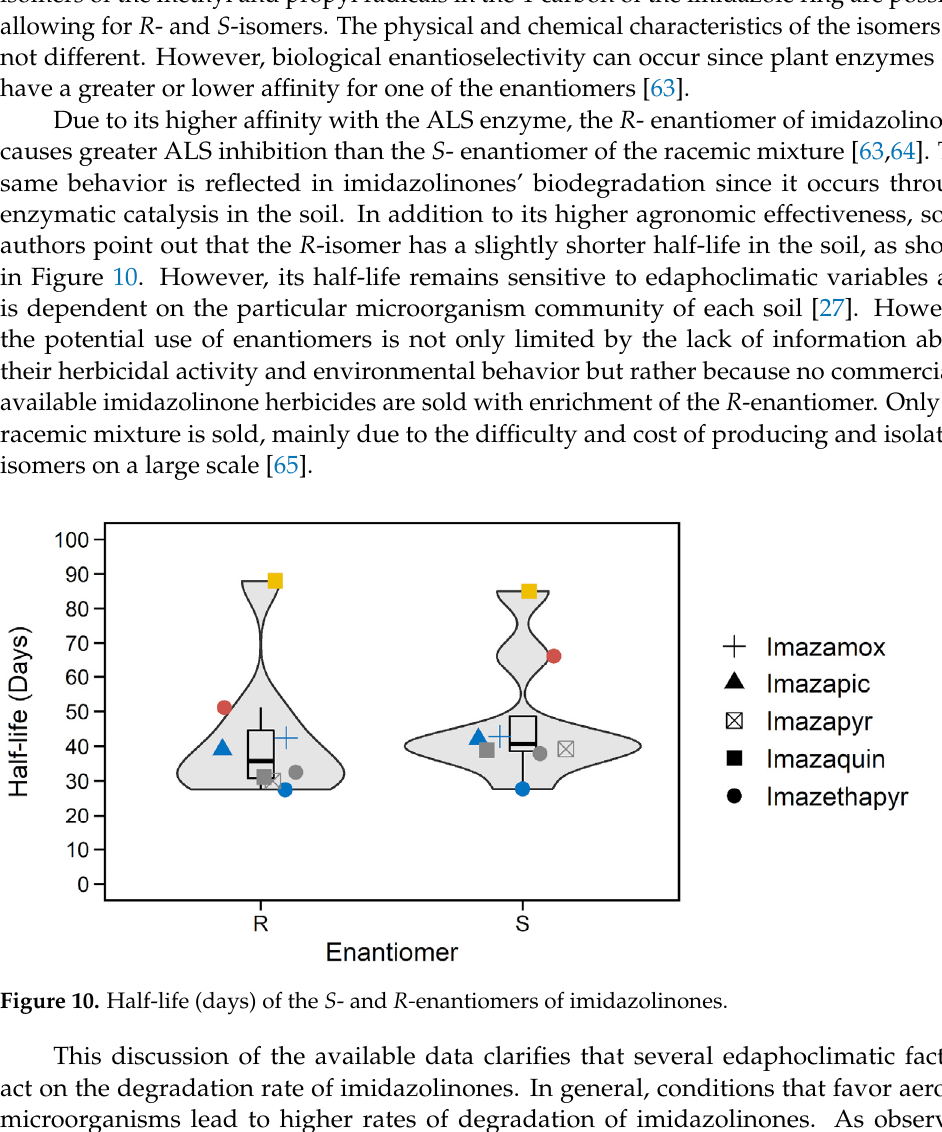
Figure 9. Effect of temperature on the half-life of imidazolinones (in days).